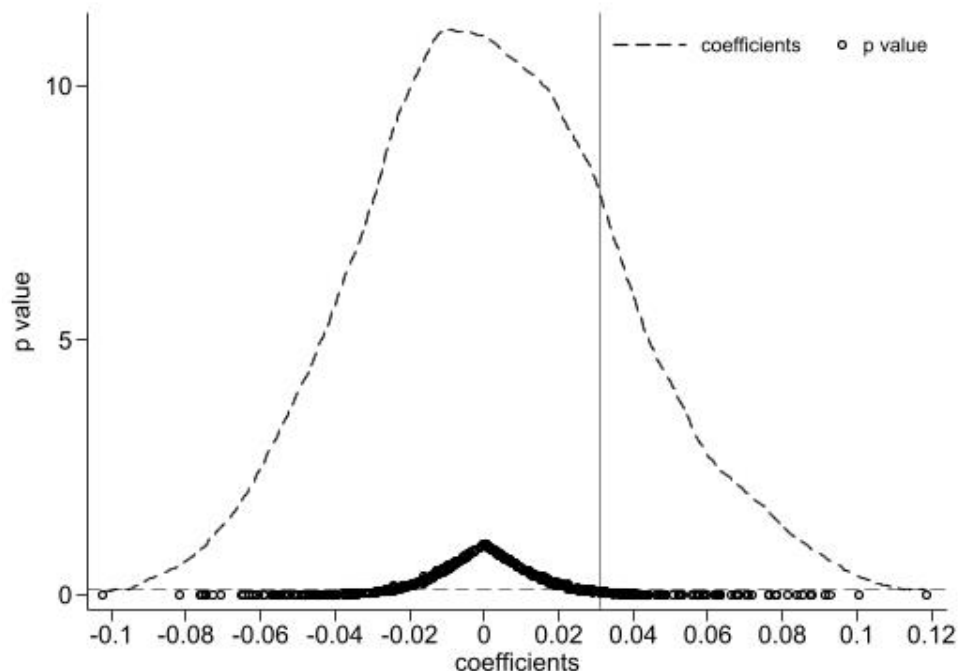
Figure 2. The result of the placebo test. Note: The vertical line on the left side of the figure represents the actual estimated coefficient. The horizontal dashed line at the bottom of the figure represents p = 0.1.